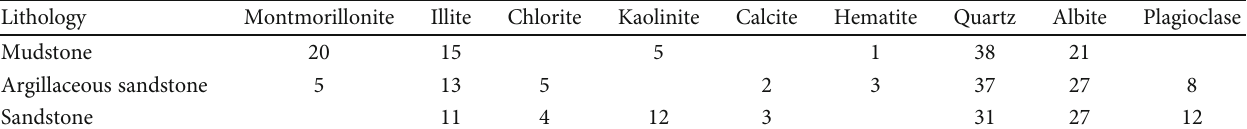
Table 1: X-ray di ff raction results (unit: %).